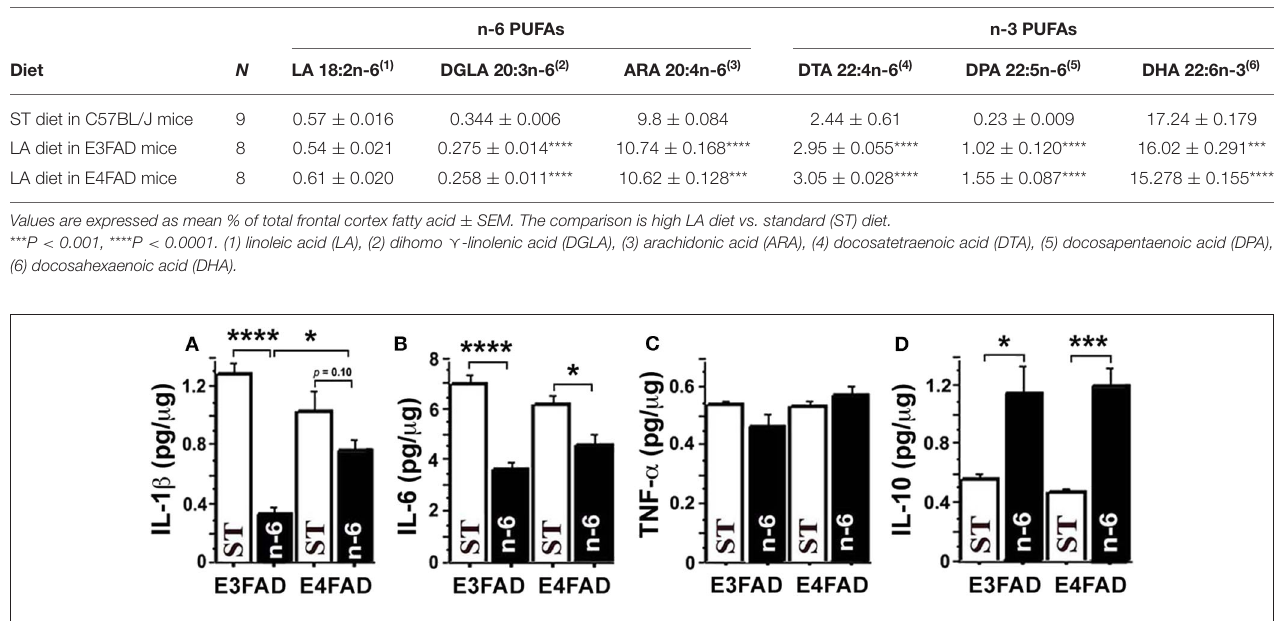
TABLE 1 | Polyunsaturated fatty acids (PUFAs) content in frontal cortex of EFAD mice.